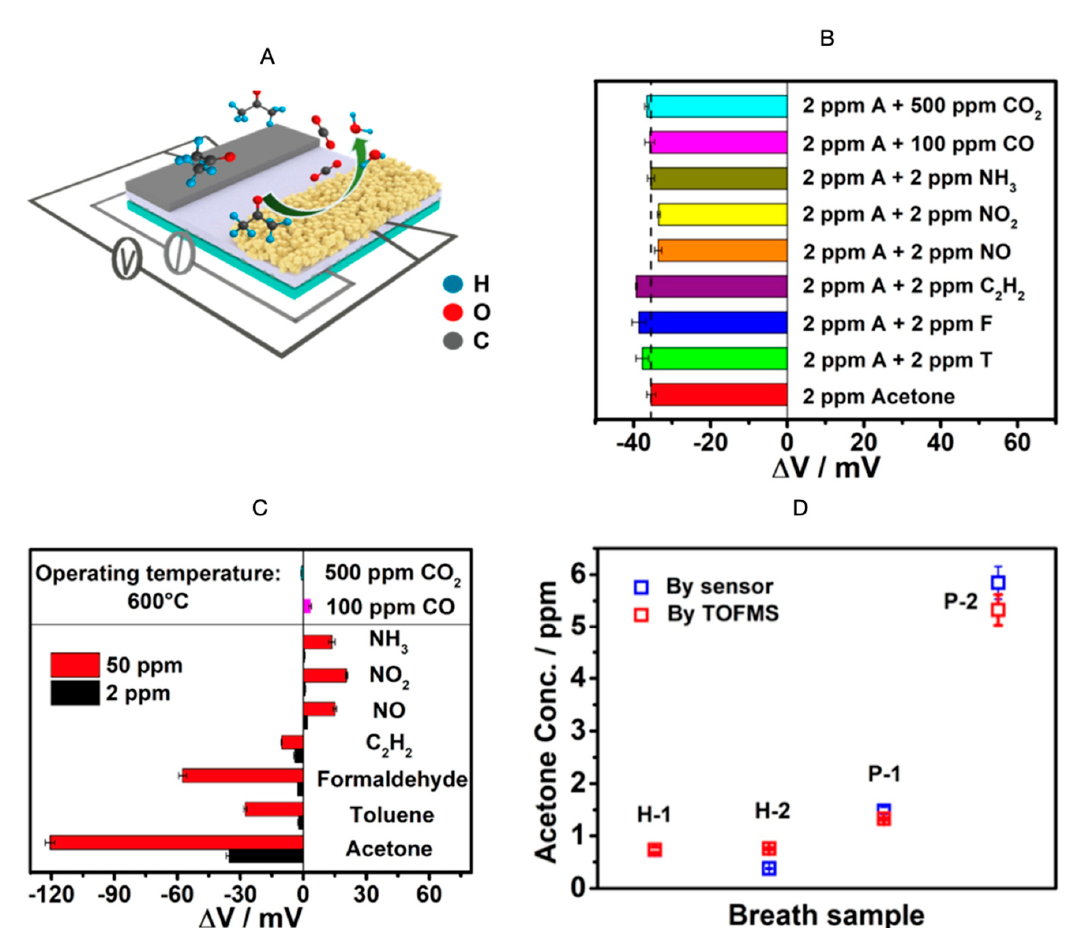
Figure 7. ( A ) Schematic diagram of measurement; ( B ) Cross-sensitivities of the sensor to the gas mixtures of 2 ppm acetone and other interference gases; ( C ) Selectivity of the sensor to various gases at 600 °C; ( D ) Acetone concentration in the breath sample calculated by the sensor and tested by TOFMS (H: Healthy; P: Patient) [103]. Reprinted with permission from Elsevier.